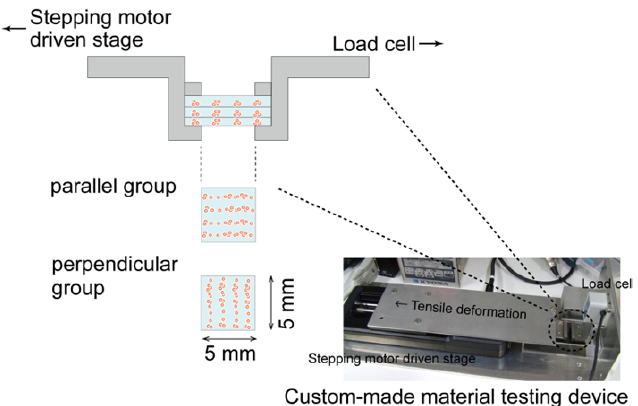
Figure 5. Evaluation of the mechanical properties of layered gel-sheet constructs. Specimens were stretched parallel or perpendicular to the cellular alignment in the gel-sheet construct.